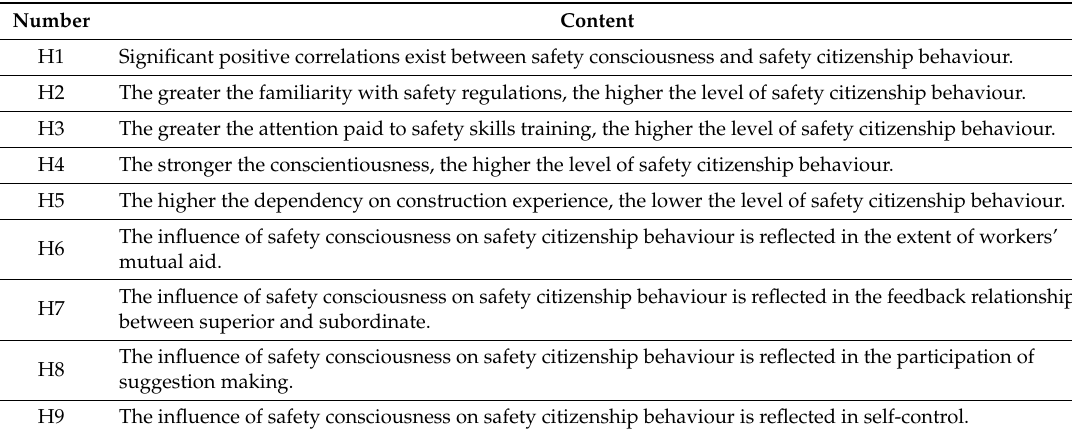
Table 2. Research hypotheses for the relationship between safety consciousness and safety citizenship behaviour for construction